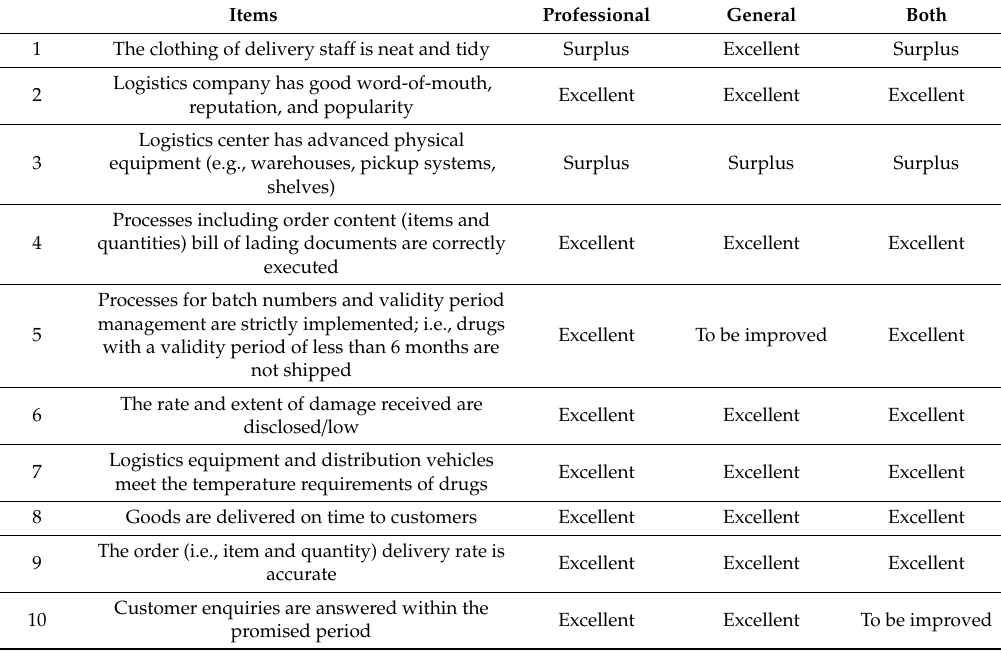
Table 7. IS analysis of di ff erent pharmaceutical logistics service providers. Items Professional General